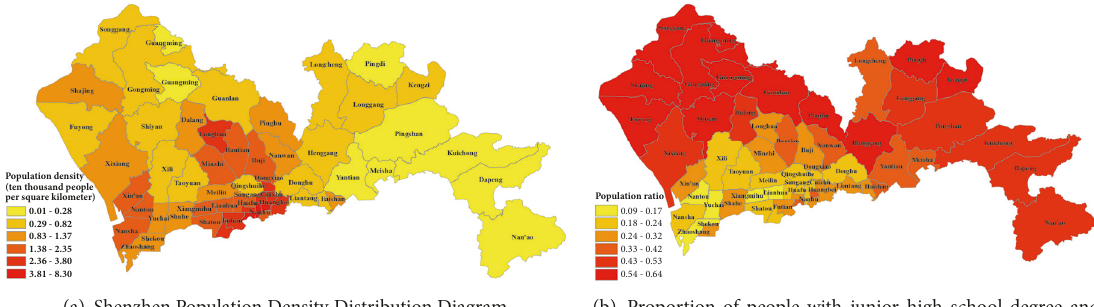
Figure 9: Shenzhen population